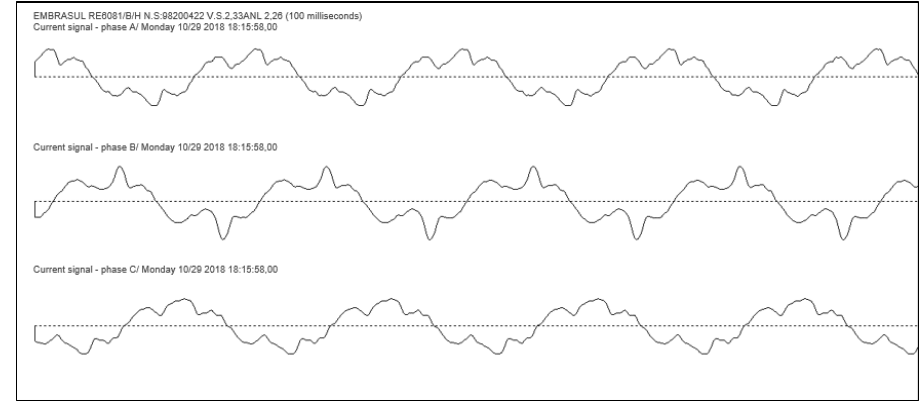
Figure 7: Current input to UPS B.